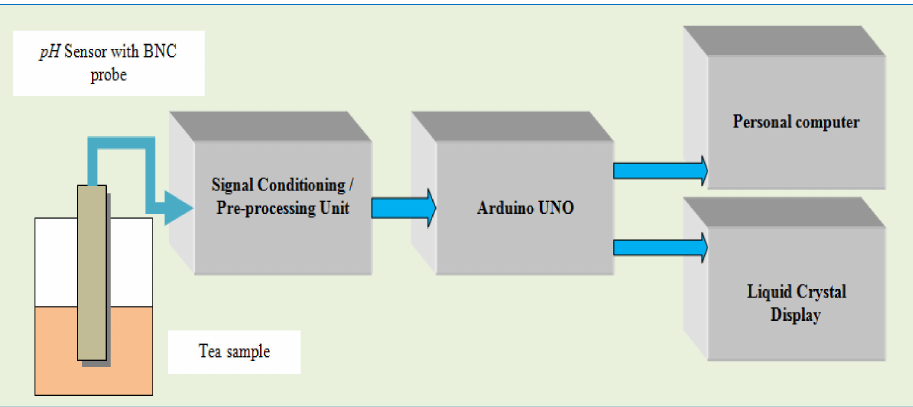
Figure 7. Sensing mechanism of tea sample using Arduino